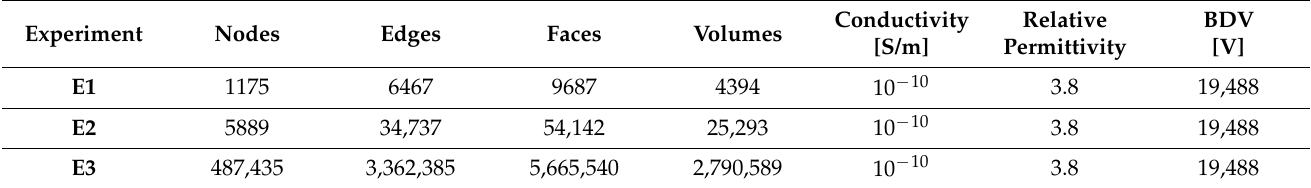
Table 1. Mesh characteristics and physical properties considered in the numerical experiments.